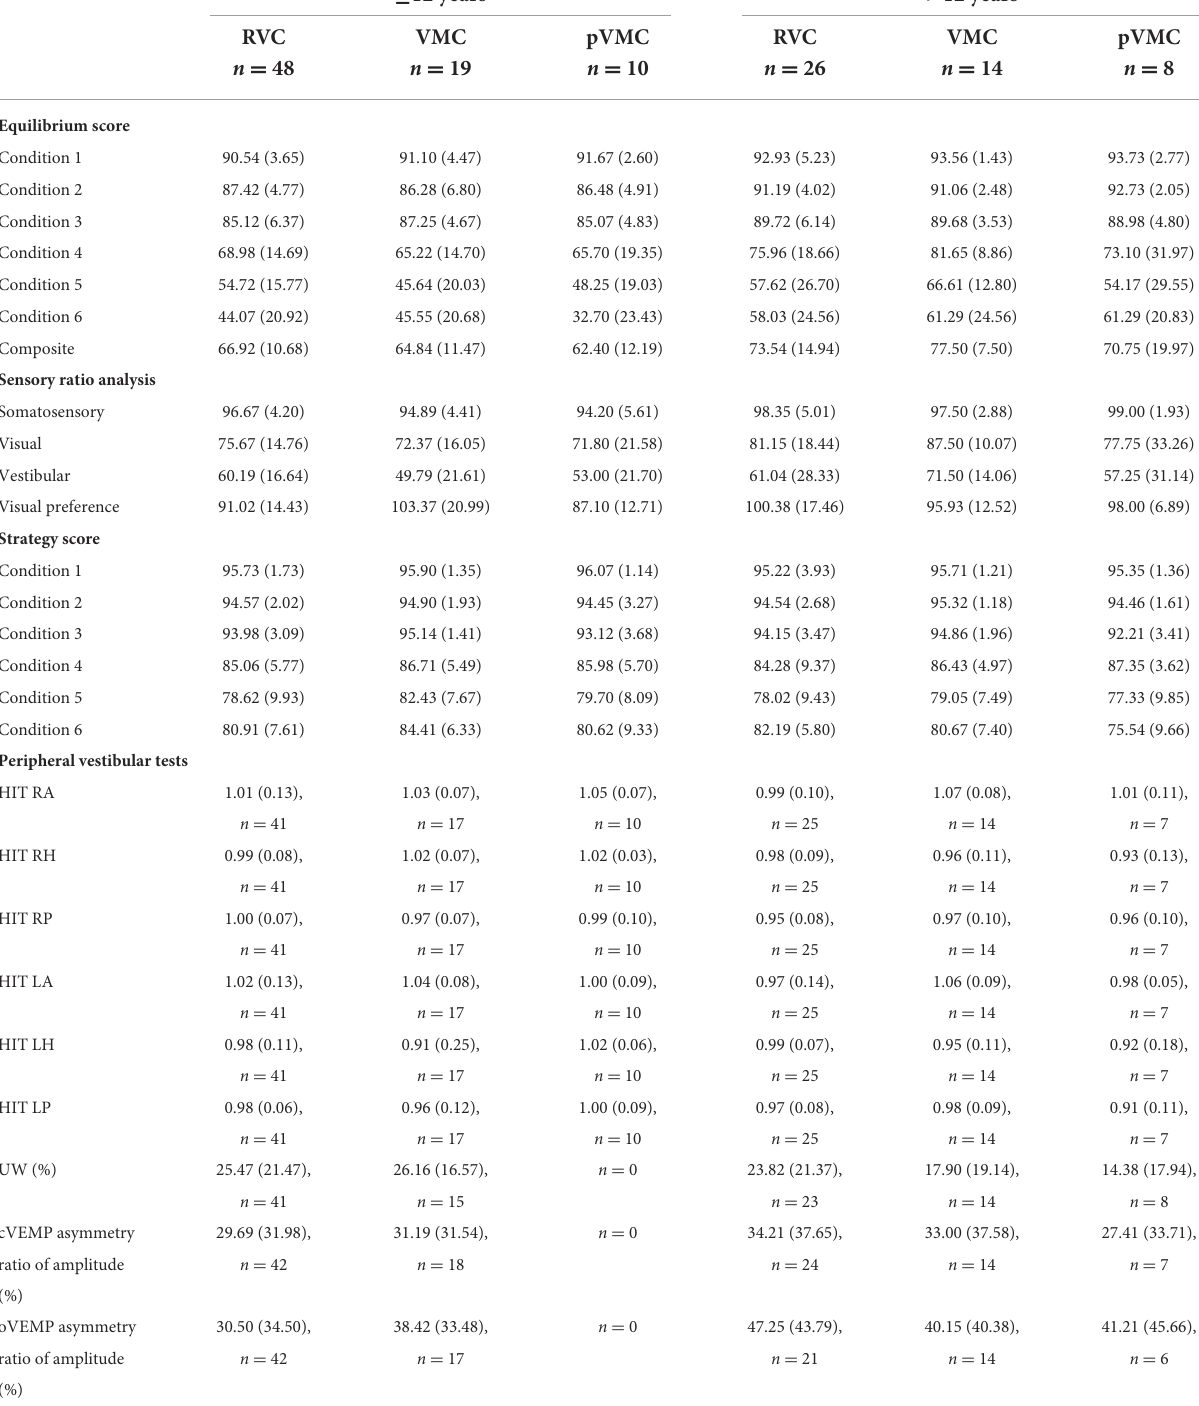
TABLE 2 Mean values of variables in different ages and